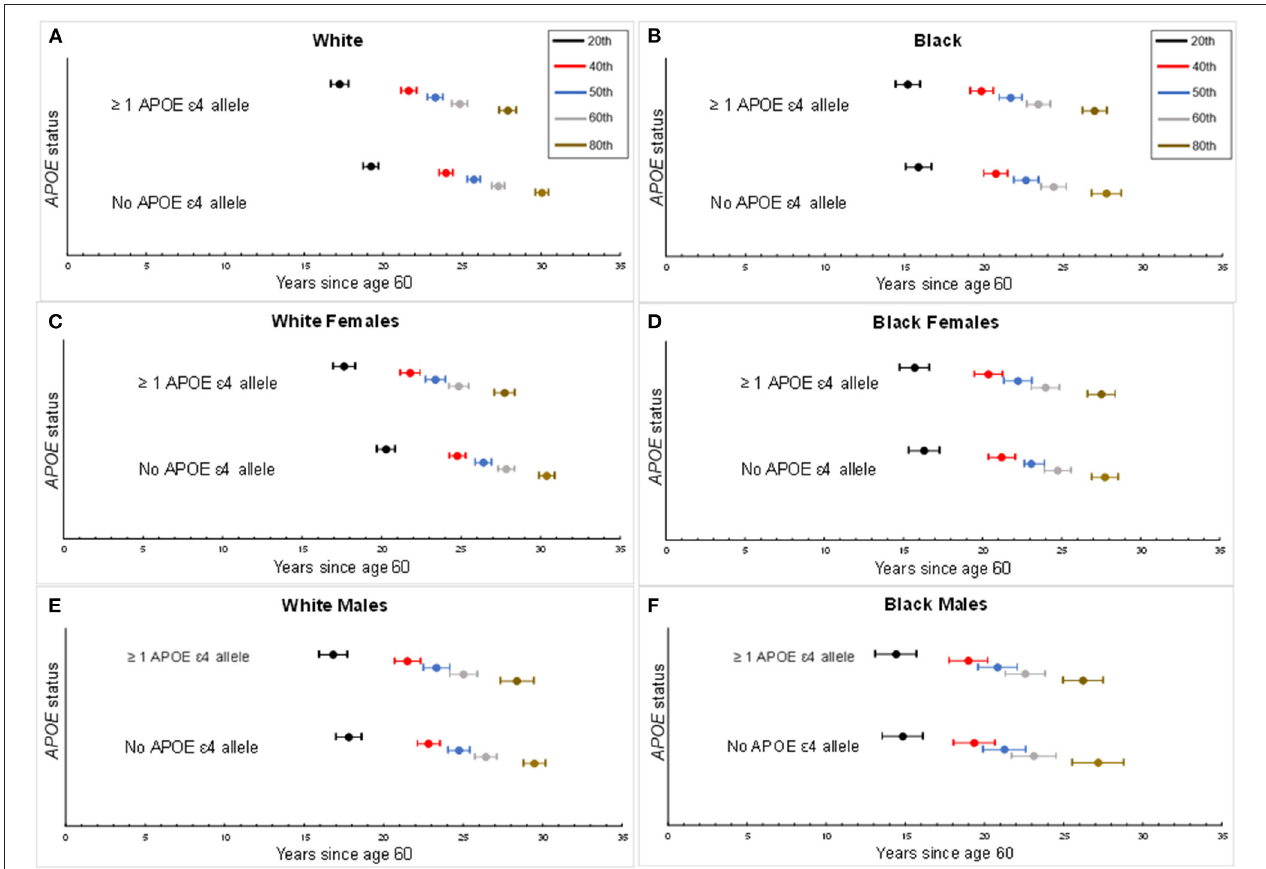
FIGURE 2 | Percentiles for age of dementia diagnosis by APOE status. Percentiles of age of dementia diagnosis made by APOE ε 4 carrier status, accounting for the competing risk of death. Center circle per horizontal bar represents the estimated age of onset of dementia for a given percentile of the study population with the corresponding 95th percentile confidence interval. Each percentile depicts the proportion of dementia diagnosis experienced by age per subgroup. (A) Age of dementia diagnosis by White overall study sample. (B) Age of dementia diagnosis by Black overall study sample. (C) Age of dementia diagnosis for White females. (D) Age of dementia diagnosis for Black females. (E) Age of dementia diagnosis for White males. (F) Age of dementia diagnosis for Black males.